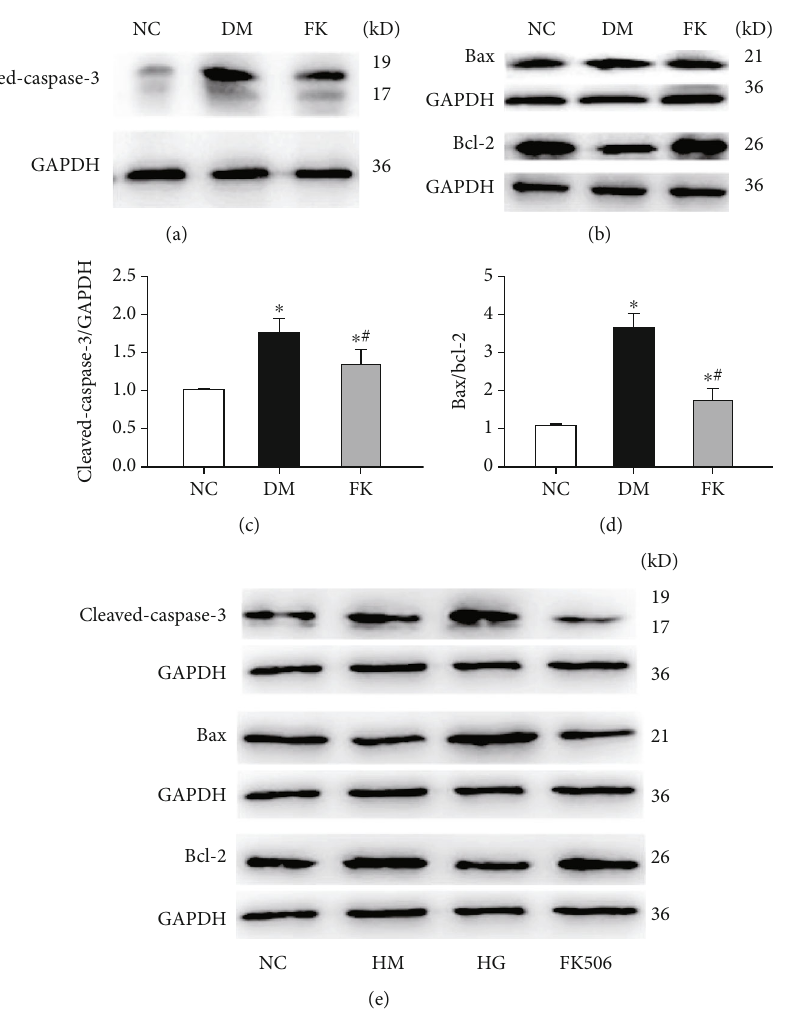
Figure 8: Western blot analysis of cleaved-caspase-3 and bax/bcl-2. Expressions of all above apoptotic proteins in the DM group were signi fi cantly increased compared with the NC group, and FK506 suppressed the apoptosis (a – d). Similar results were found in mouse podocytes (e). GAPDH: glyceraldehyde-3-phosphate dehydrogenase. ∗ P < 0 : 05 compared to the NC group, ∗ # P < 0 : 05 compared to the DM